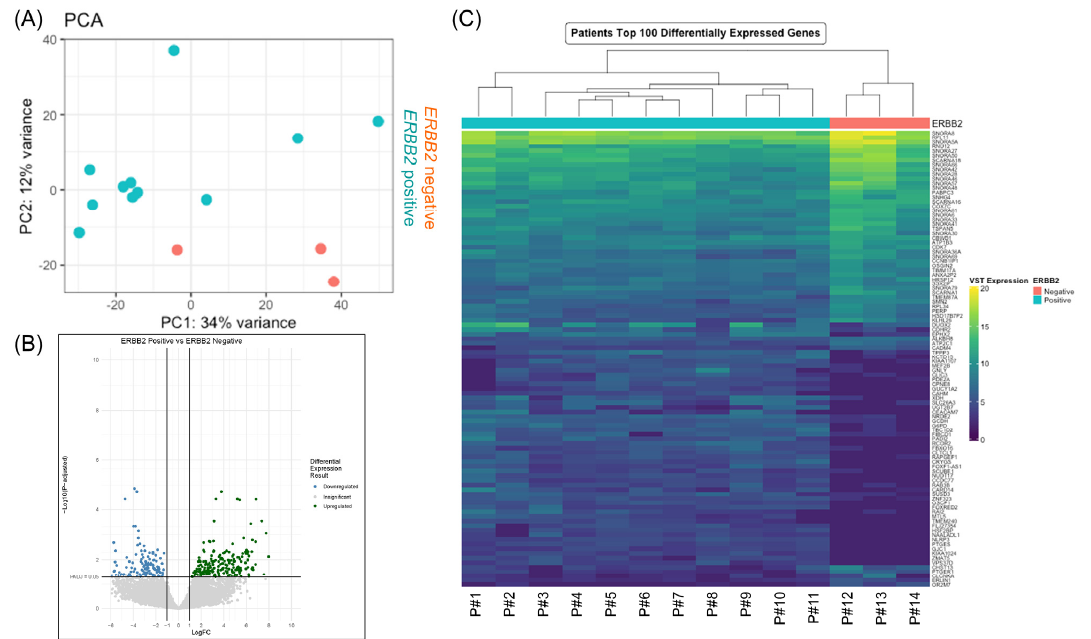
Figure 4. Genome-wide gene expression changes between ERBB2 + and ERBB2 − CRC patients. ( A ) Principal component analysis (PCA) was performed to determine batch effects among the 14 patients’ samples. Comparison of PC1 and PC2 variation sequestered the samples based on ERBB2 expression. ( B ) Volcano plot of differentially expressed genes between ERBB2 - and ERBB2 + patients’ samples from input RNA-seq. Genes that are expressed significantly higher and lower based on log2 fold change in HER2+ samples are highlighted by green and blue dots, respectively. Unchanged transcripts are demarcated as grey circles ( p > 0.05). ( C ) Heatmap of the top 100 differentially expressed genes.